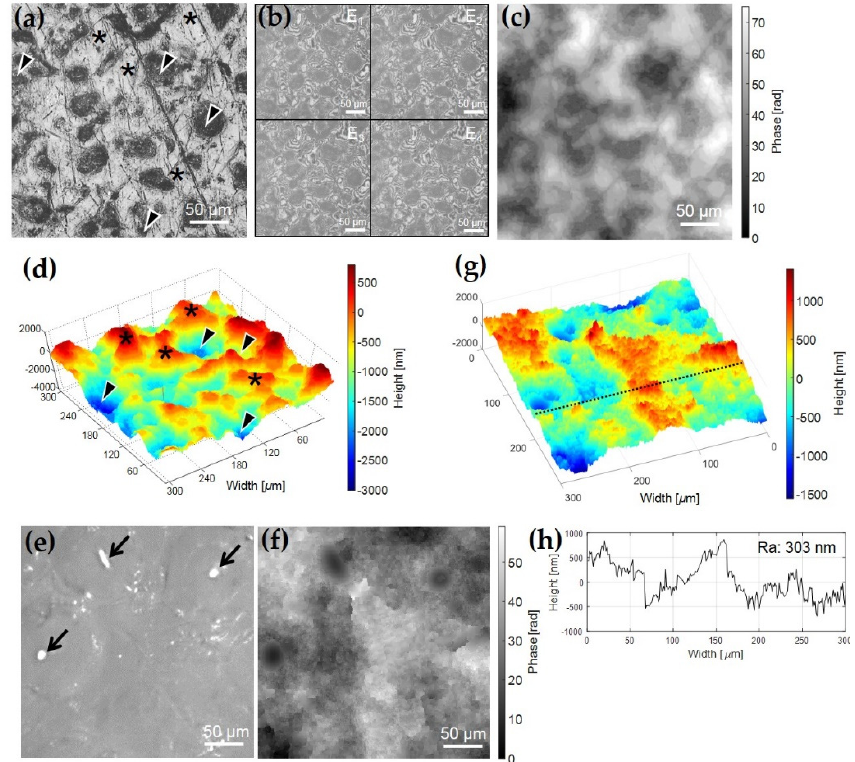
Figure 4. Surface mapping of a pad-like sample and a used CMP pad. ( a ) A microscope image (300 × 300 μ m) of the porous surface of an anodized aluminum plate. ( b ) Phase-shifted interference images of the plate. ( c ) A phase-shifted contrast image. ( d ) A topology of the surface map. ( e ) A microscope image of the processed CMP pad surface immersed in a diluted emulsion, where arrows indicate the top of air bubbles trapped in the pores, which were removed before PSI. ( f ) A phase-shifted contrast image of the CMP pad surface. ( g ) The topology of the CMP pad surface map. ( h ) A 1-D surface profile taken along the dotted line in ( g ).